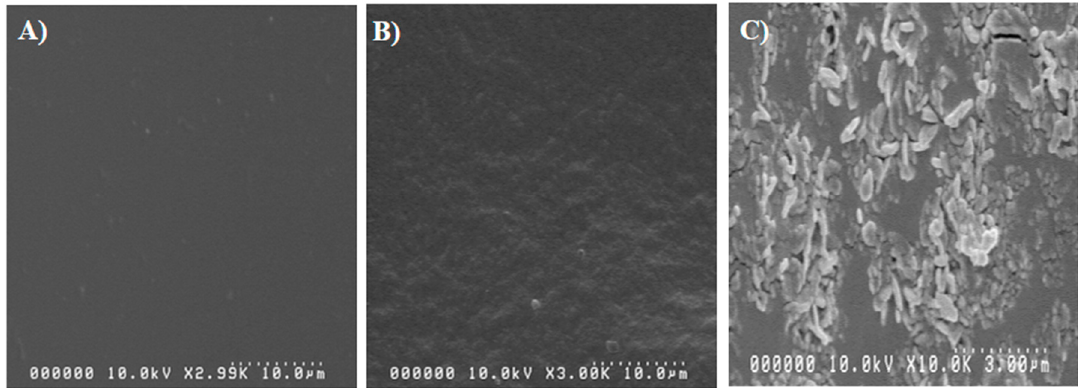
Figure 7. SEM images of ( A ) surface of PAm, ( B ) surface of PAC3, and ( C ) cross-section of PAC3.